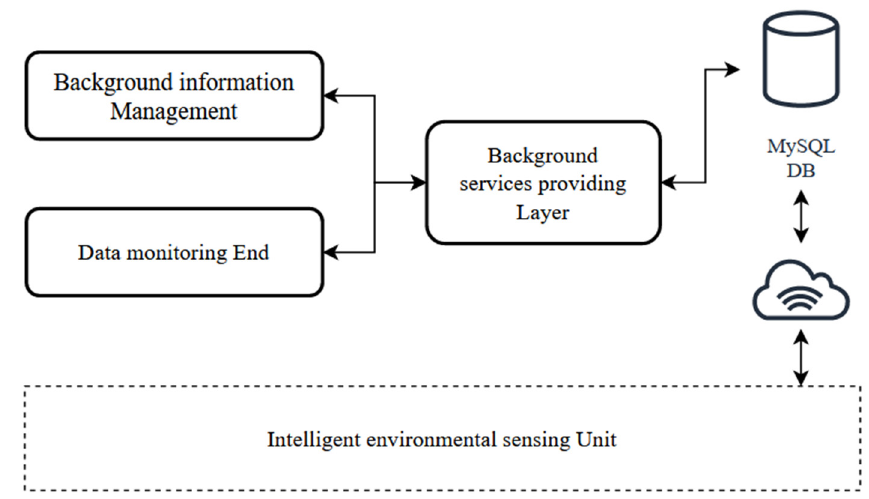
Figure 10. The architecture of the application layer.